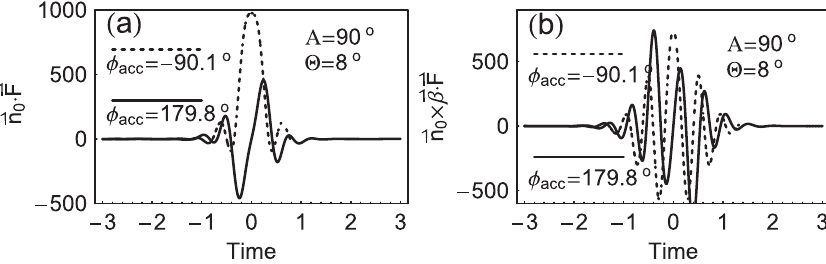
FIG. 9. The Lorentz forces experienced the selected electrons as functions of time. The corresponding integrated momentum (cid:9) ~(cid:9)=(cid:8) reduce from 461 to 0.8 in (a) and from 12.5 to 0.03 in =(cid:8) and c ~P (cid:13) ~n transfers c ~P (cid:13) ~n 0 0